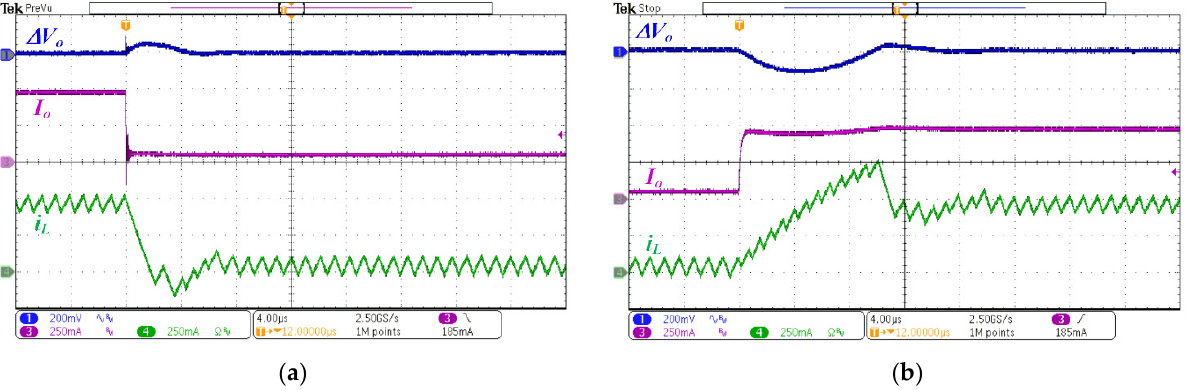
Figure 15. Measured transient waveforms of the proposed buck converter for ( a ) step-down and ( b ) step-up loads.